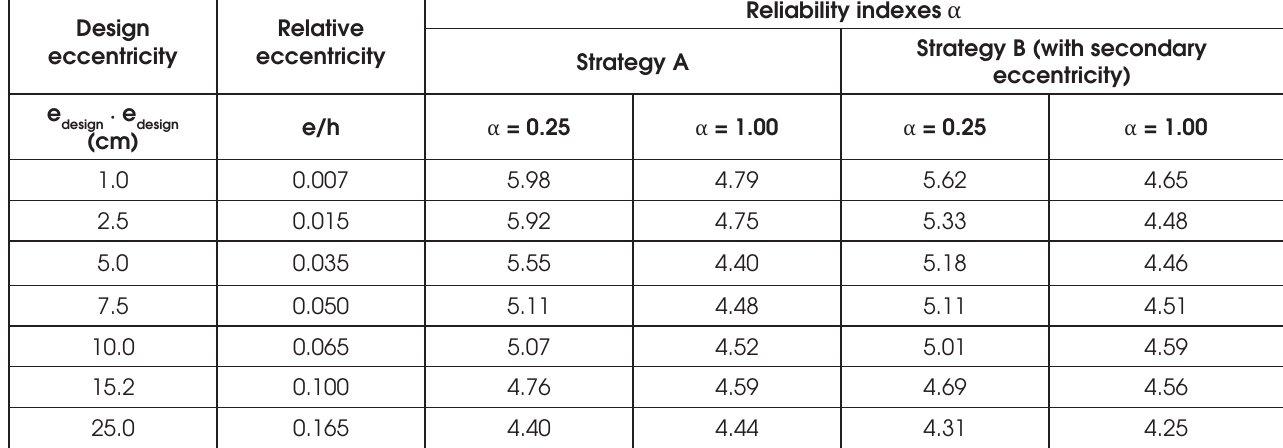
Reliability indexes